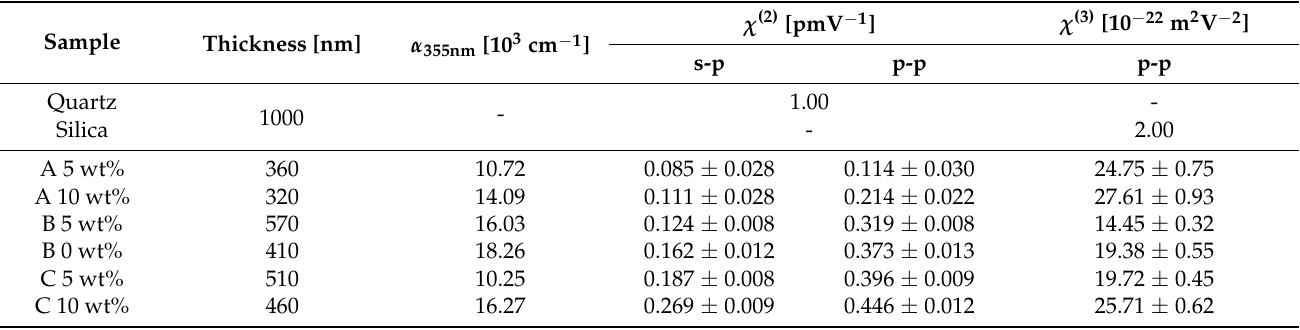
Table 3. The thickness of the layers of the tested samples, the absorption coefficients assigned to them, and effective χ (2) and χ (3) values obtained for A, B, and C films in PVK matrix, taking into account experimentally measure data.